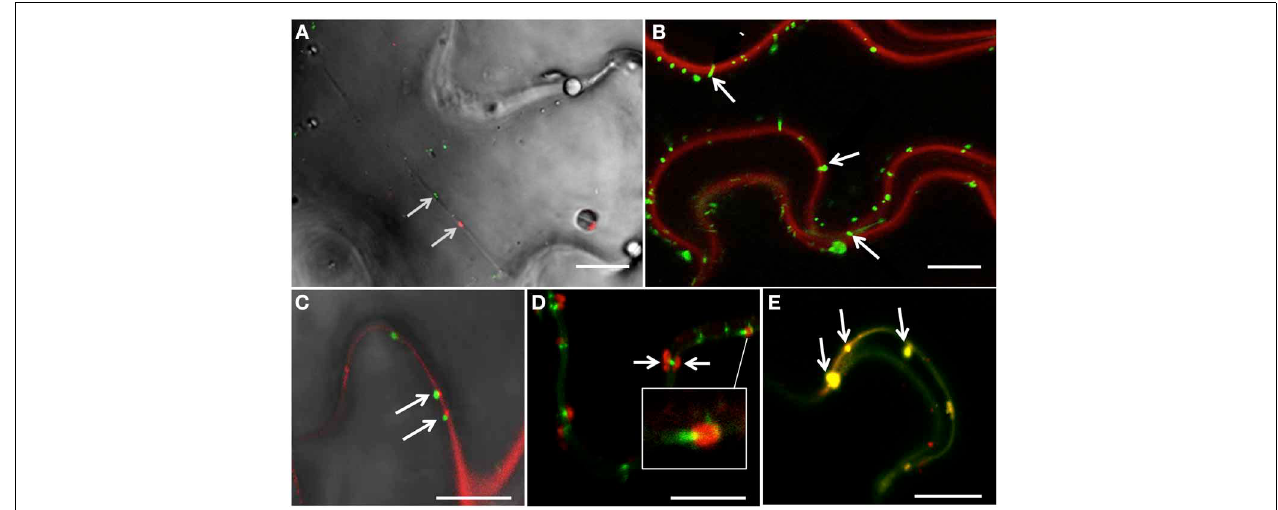
FIGURE 1 | 6K 2 -induced vesicles reach the plasma membrane and plasmodesmata. (A) Confocal image of a N. benthamiana cell infected with TuMV producing 6K 2 :mCherry and expressing PDLP1:GFP, with bright-field illumination. Arrows indicate the positioning of PDLP1:GFP and one 6K 2 vesicle in a transvacuolar strand. (B) Confocal image of N. benthamiana cells infected with TuMV producing 6K 2 :GFP and stained with FM4-64 for plasma membrane labeling. Arrows indicate the presence of 6K 2 vesicles anchored to the plasma membrane. (C) Confocal image of N. benthamiana cells infected with TuMV producing 6K 2 :GFP and expressing